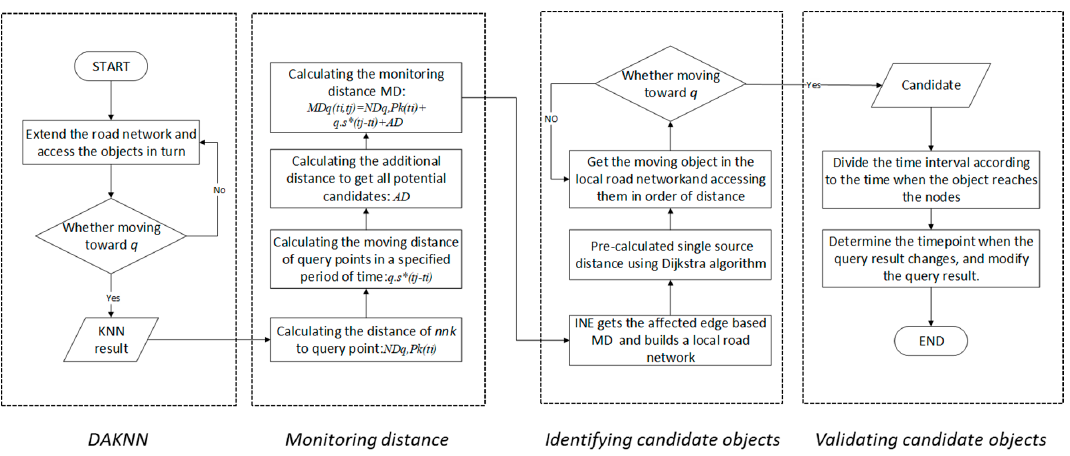
Figure 4. Direction-aware continuous moving K -nearest neighbor (DACKNN) algorithm process diagram.